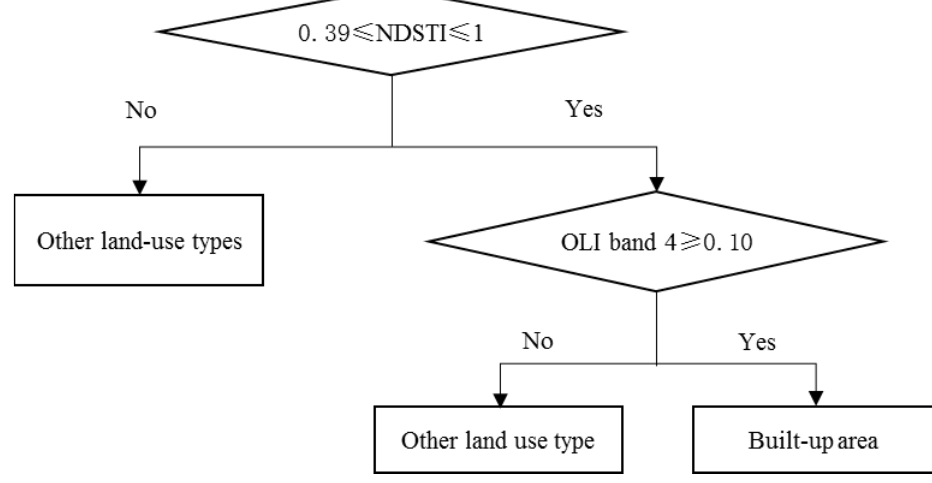
Figure 6. The decision tree for built-up area extraction in experimental study area.